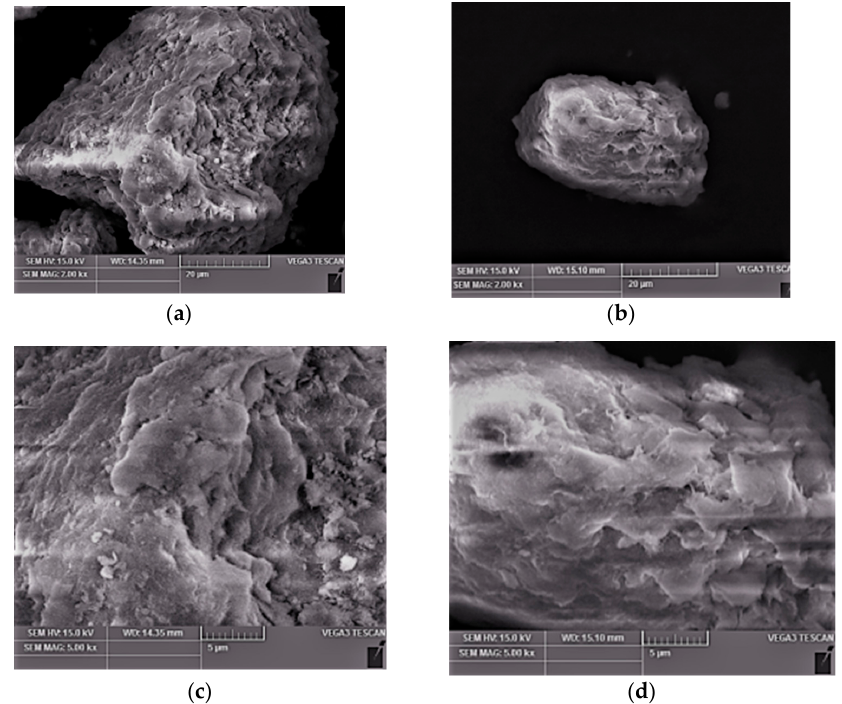
Figure 8. ( a ) SEM image of original soil, ( b ) modified catalyst, ( c ) original soil, ( d ) modified catalyst. The ATP and modified ATP were characterized using XRD, and the changes of ma- terials in ATP and modified ATP were compared. The XRD results are shown in Figure 9.